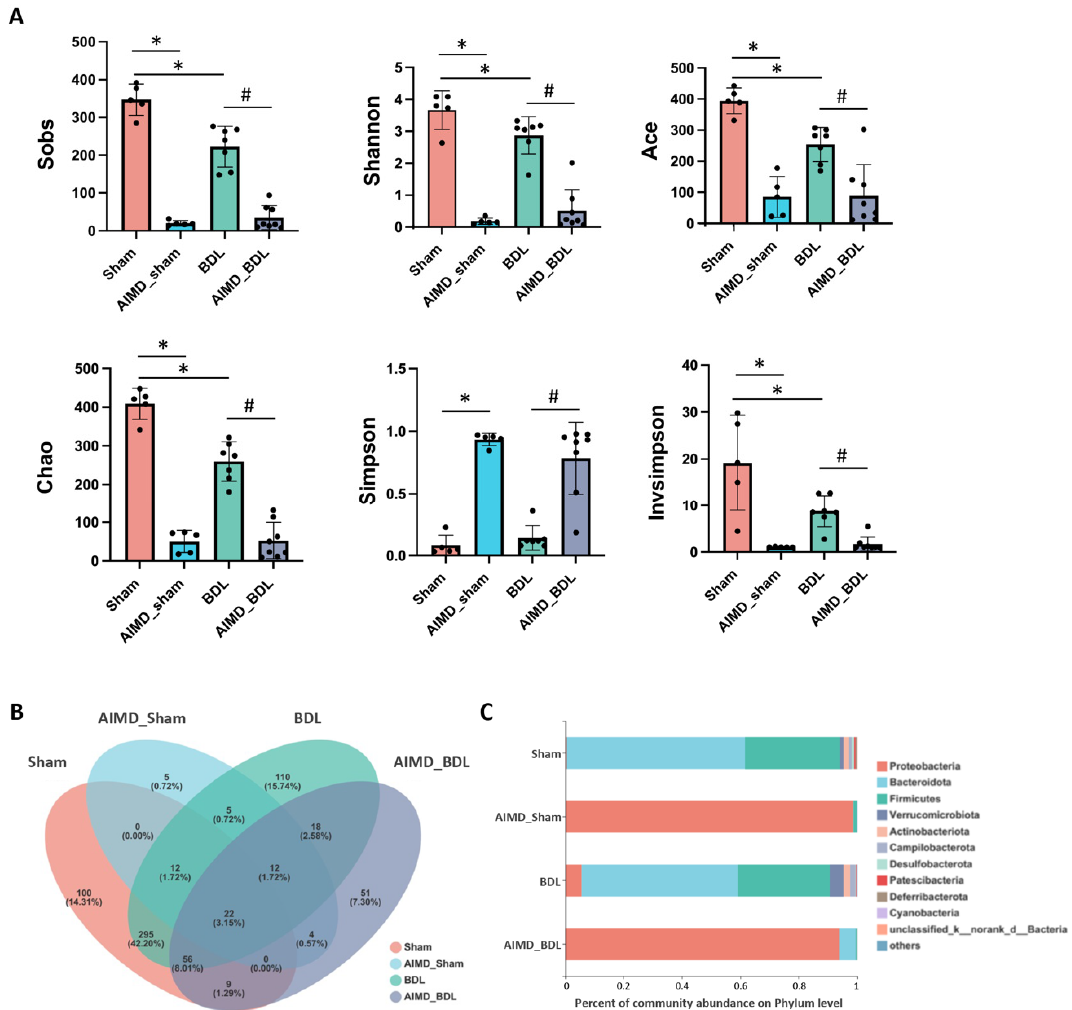
Figure 2. ( A ) Within-sample α -diversity analysis of gut microbiota, including Sobs, Shannon, Ace, Chao, Invsimpson, and Simpson in four groups. Sham, n = 5; AIMD_Sham, n = 5; BDL, n = 7; AIMD_BDL groups, n = 8. * p < 0.05 vs. Sham group; # p < 0.05 vs. BDL group. ( B ) Venn diagrams of OTUs for four groups. ( C ) The composition of the four groups at the phylum level.